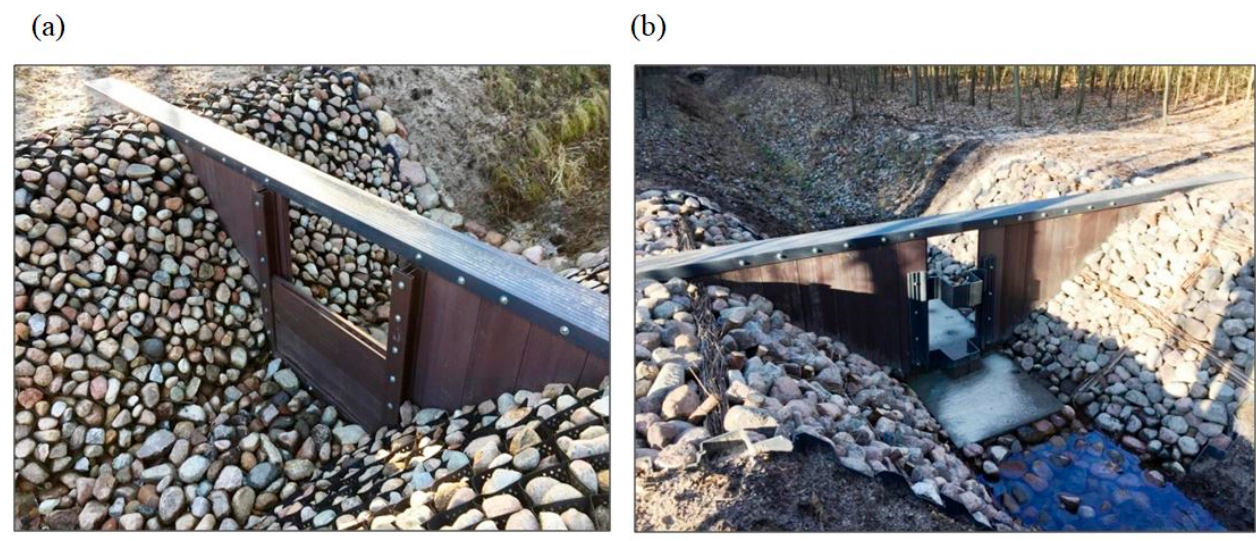
Figure 1. Beam regulators: ( a ) rectilinear beam, ( b ) compound beam (photo by R . Oleszczuk).